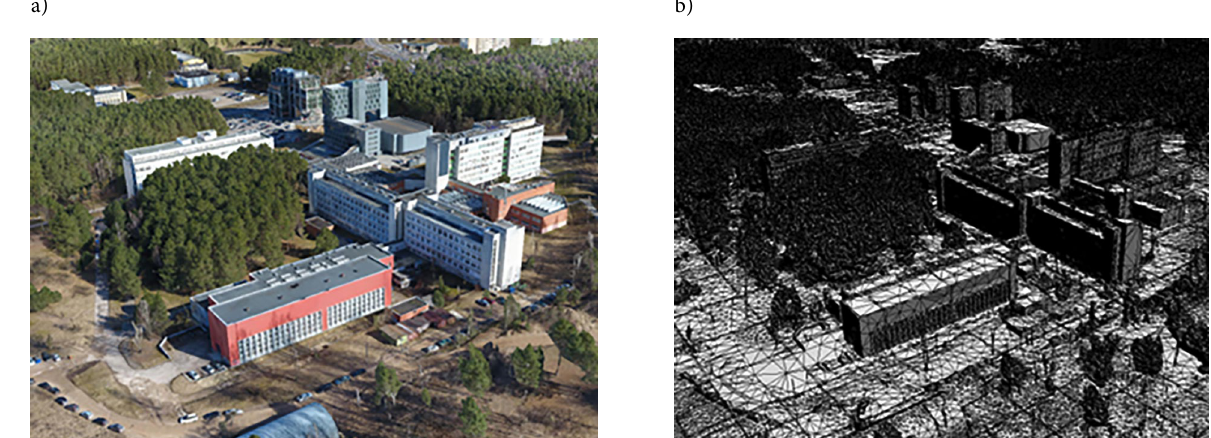
Figure 3. The photogrammetry model and point